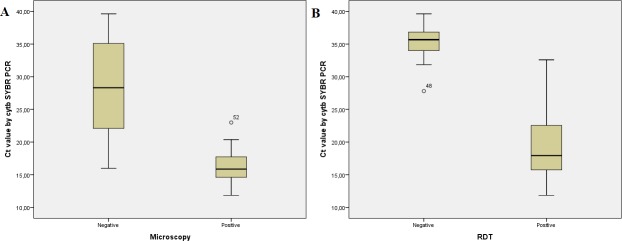
Boxplots showing how research microscopy and RDT results correlate to positive Ct values among Tanzanian field samples.(A) A boxplot showing how research microscopy results negative/positive correlate to positive cytb SYBR real-time PCR results (N = 54). (B) A boxplot showing how rapid diagnostic test (RDT) results negative/positive correlates to positive cytb SYBR real-time PCR results (N = 47).